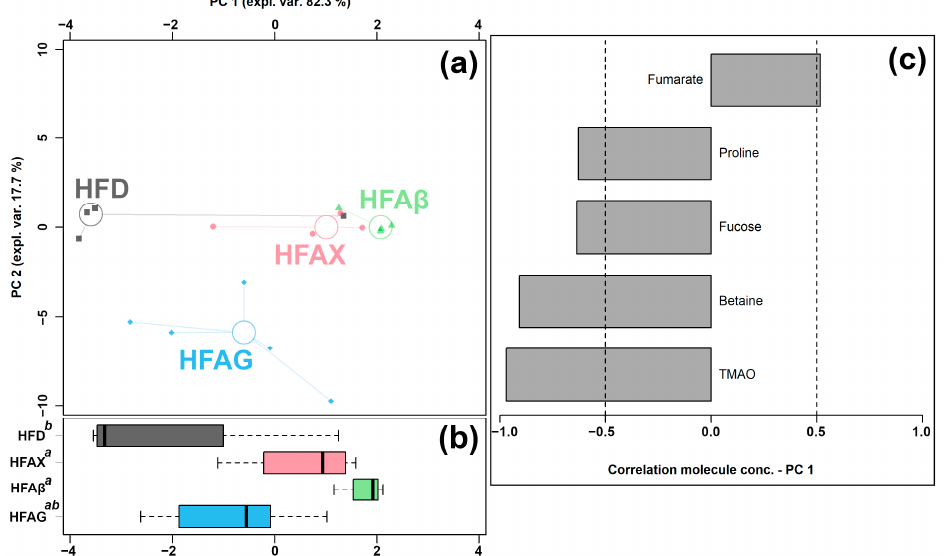
Figure 5. rPCA model was performed on the basis of molecules whose concentrations showed significant differences among HFD, HFAG, HFAX, and HFA β groups. Scoreplot ( a ) shows the overall structure of the data and boxplot ( b ) highlights the position of the samples along PC 1. The comparisons among the groups are represented by a compact letter display, where group names followed by a common superscript identify no significant differences. Loading plot ( c ) shows the significant relationships between the concentration of each molecule and its importance over PC 1 ( p < 0.05).